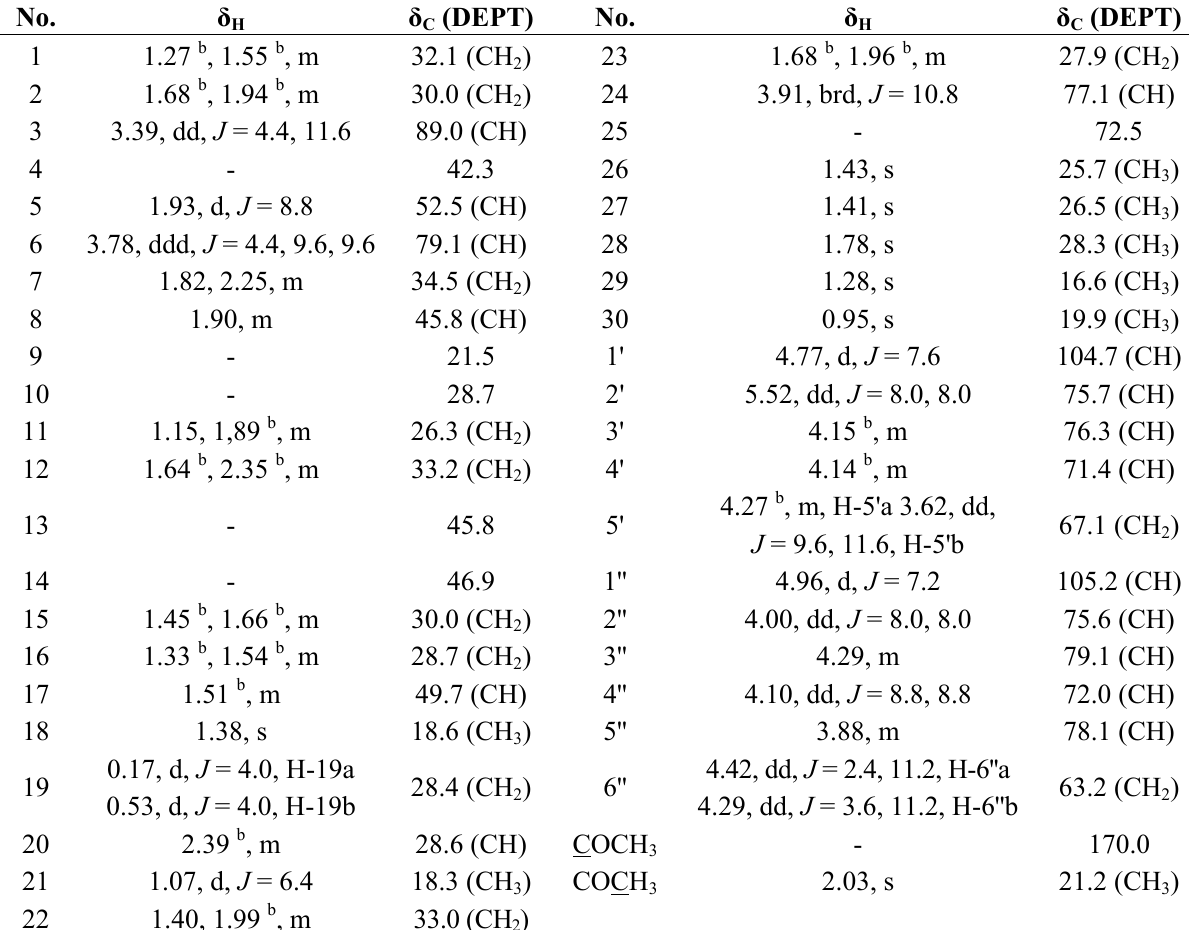
Table 1. 1 H- (400 MHz) and 13 C-NMR (100 MHz) data of compound 1 (in pyridine- d δ in ppm, J in Hz) a .